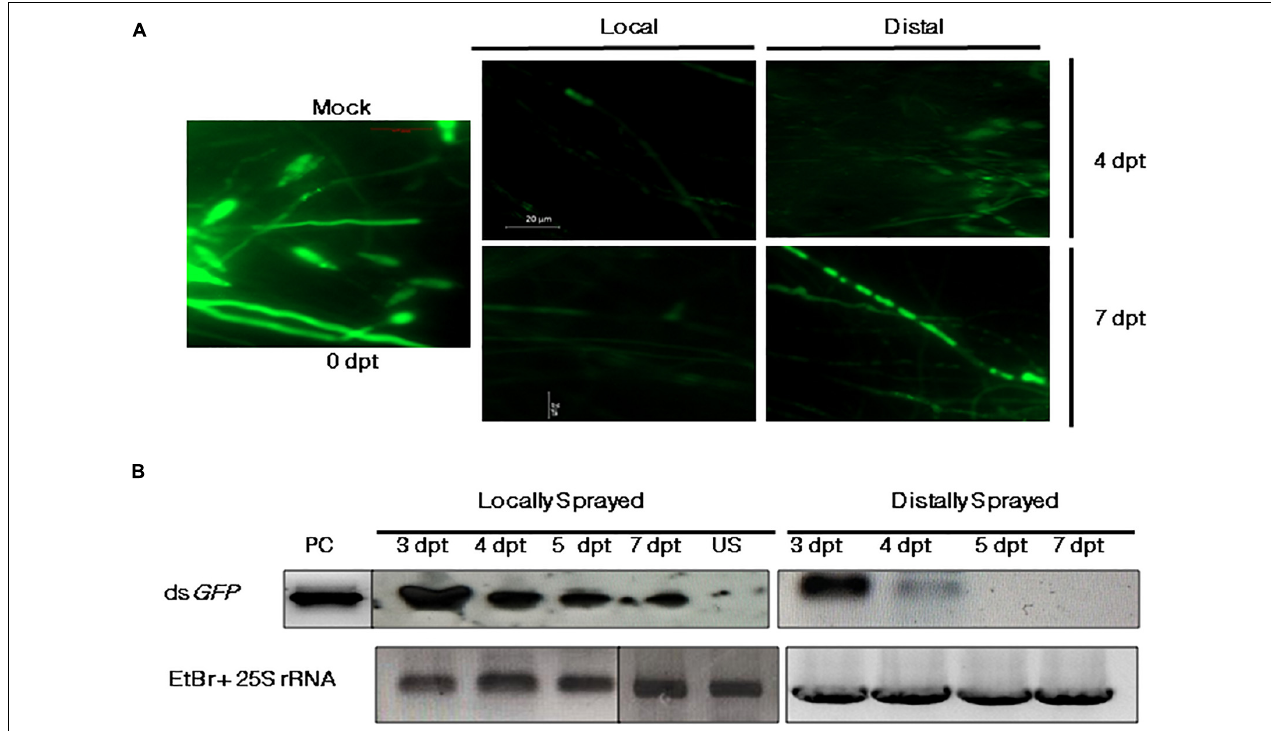
FIGURE 3 | Systemic silencing activity of dsRNA and its accumulation in the local (sprayed) and distal (unsprayed) leaves. (A) Fluorescence microscopy of wounded M. oryzaeGFP -inoculated leaves that were either sprayed with either TE (mock) or ds GFP in local and distal regions. Mean fluorescence intensity of GFP from approximately five plants (10 lesions) of each set was monitored 4 and 7 dpt. (B) Northern blot profile for GFP -specific dsRNA. The longevity and accumulation of RNA signals were assessed 3, 4, 5, and 7 dpt on locally and distally sprayed leaves. The total RNA isolated from unsprayed (US) leaves was run as negative control. In vitro -synthesized and purified ds GFP was used as the positive control (PC), and rice 25S rRNA was kept as the loading control. Sense GFP probe with the same sequence as the parent ds GFP and PCR-purified rice 25S rRNA (primers listed in Supplementary Table 2 ) were used for hybridization.